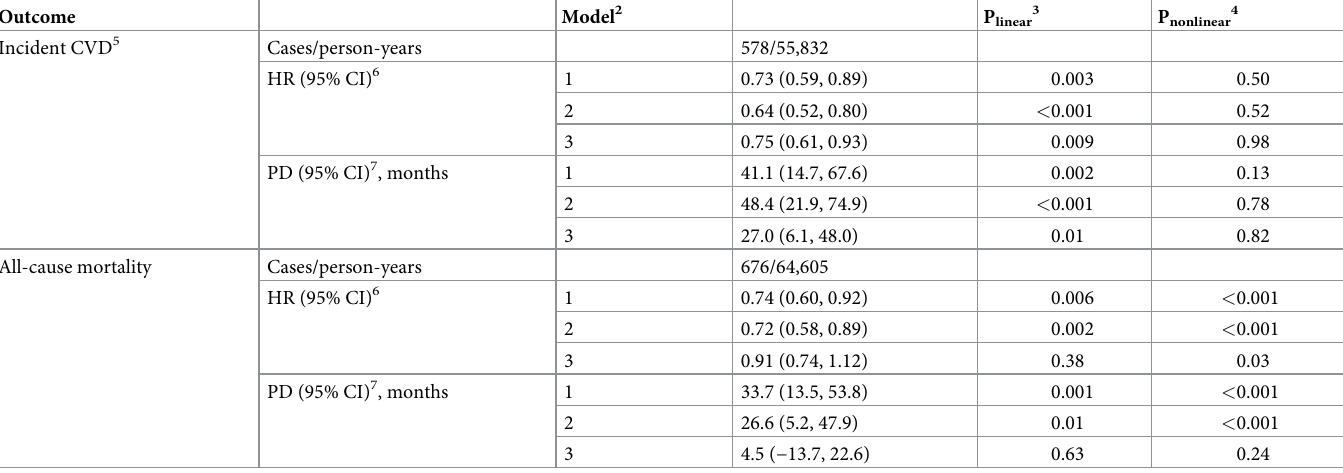
Table 2. HRs and 15th PDs of incident CVD and all-cause mortality per IQR of serum pentadecanoic acid (15:0) in the 60YO study 1 .